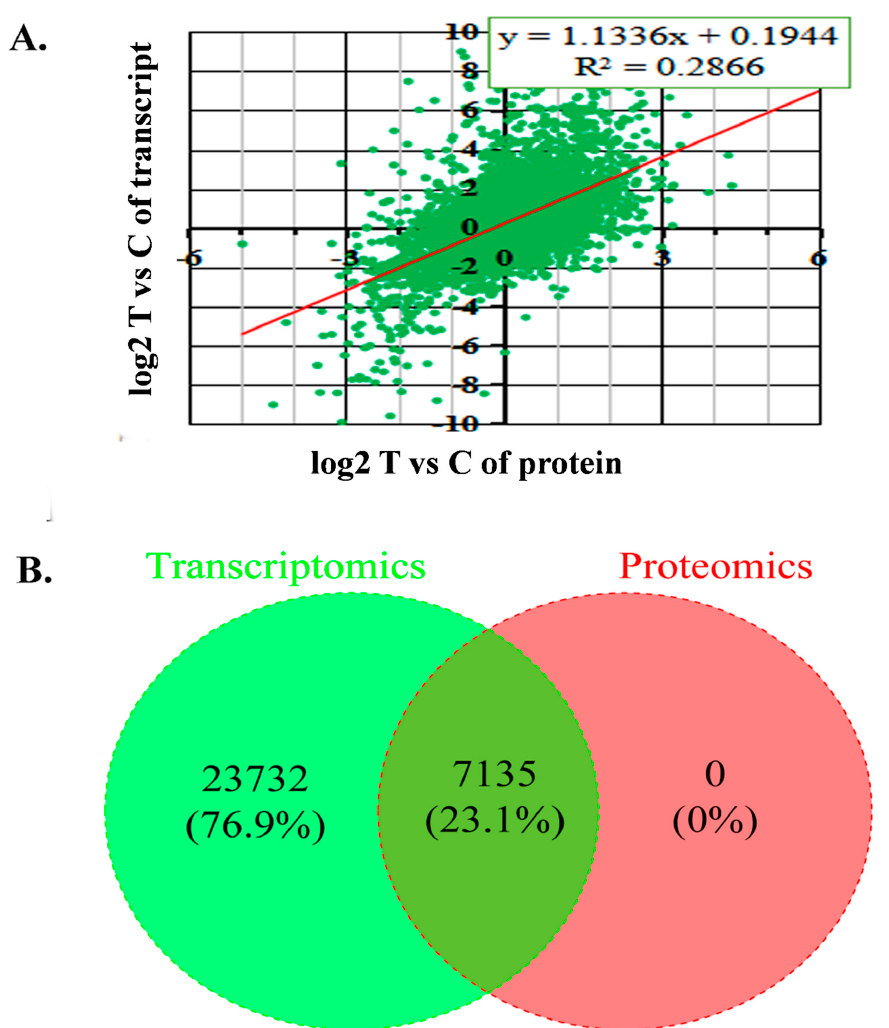
Figure 3. Correlation analysis between di ff erentially expressed genes and proteins in treated and control samples. ( A ) The x -axis illustrates the expression pattern of the di ff erentially expressed proteins (DEPs) and the y -axis illustrates the expression pattern of the di ff erentially expressed genes (DEGs) in treated and control samples. ( B ) Venn diagram shows the quantity co-regulated proteins and genes in the treated and control bud samples.